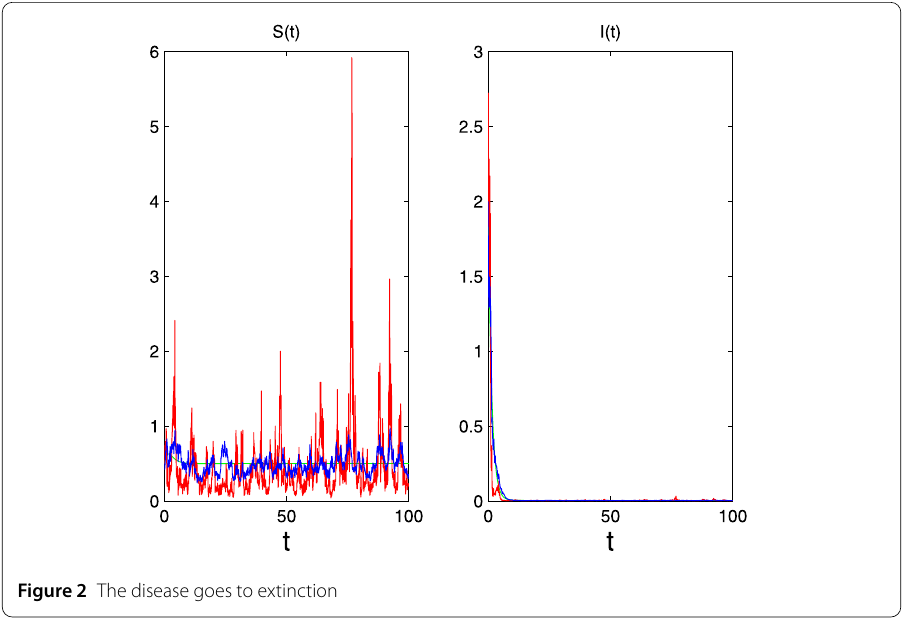
Figure 2 The disease goes to